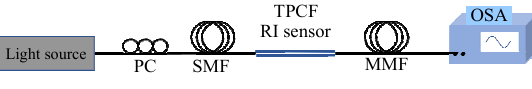
Fig. 3 Experimental setup of the sensor performance test.